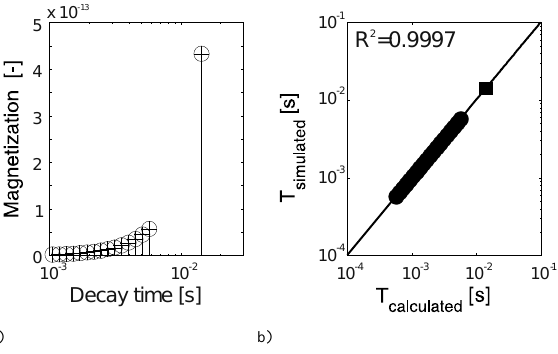
Figure 10. NMR response of an equilateral triangular capillary pore model (with a side length of 1µm). (a) Magnetization versus T 1 decay time data of numerical ( (cid:13) ) and analytical solutions ( + ) for all applied pressure levels. (b) Cross-plot of numerically simulated and analytically calculated longitudinal T 1 decay times at partial ( • ) and full water saturation ( (cid:4) ). A corresponding water saturation versus capillary pressure diagram is shown in Fig. 4.